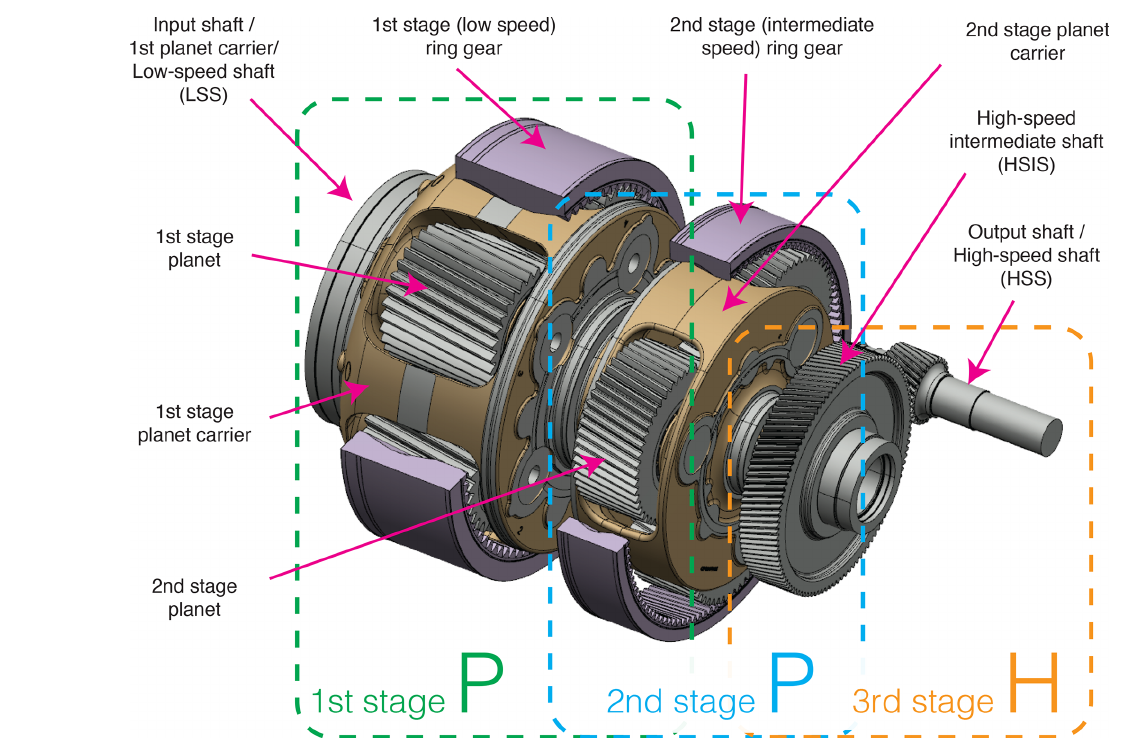
Figure 1. Assembly drawing of shafts and gears from the three-stage Siemens Gamesa Renewable Energy gearbox (PPH configuration).